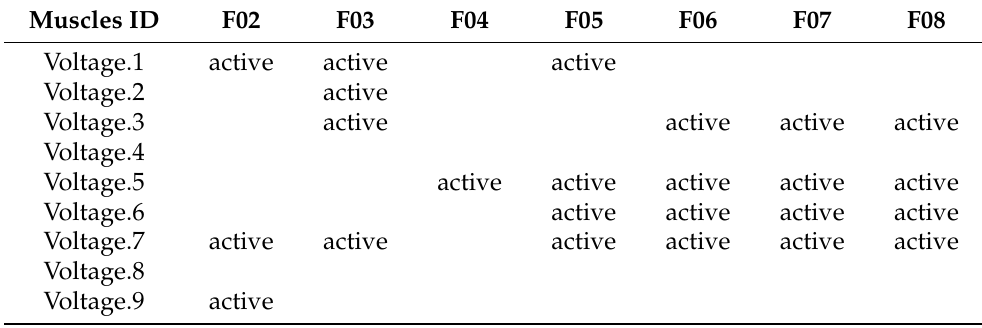
Table 5. Detected muscle (Table 3) activity in relation to movement phases (Table 4) in